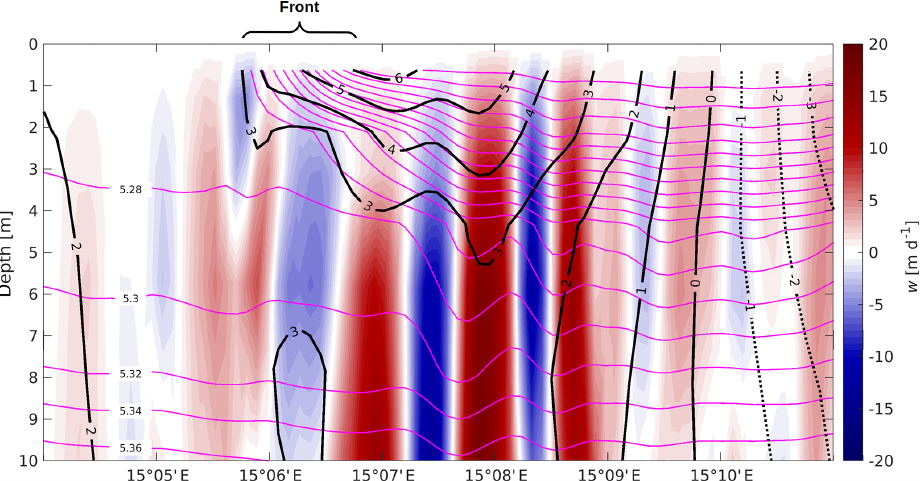
Figure 9. R100, 26 June: zonal section of vertical velocity w at 54 ◦ 49.9 (cid:48) N. Magenta contours indicate a potential density anomaly σ θ , and bold solid and dotted contours are isotachs of the meridional velocity component v (cms − 1 ). The position of the section is marked in Fig.